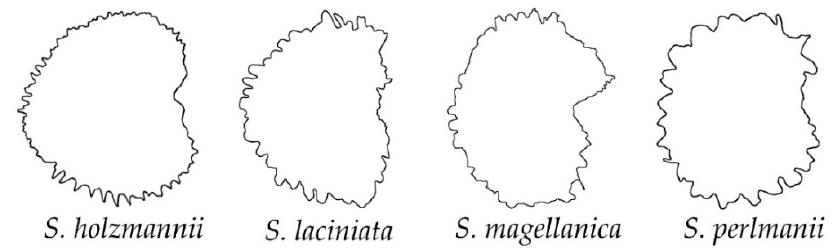
Figure 7. Silhouettes of the lateral view of seeds in the group of papillose outline.